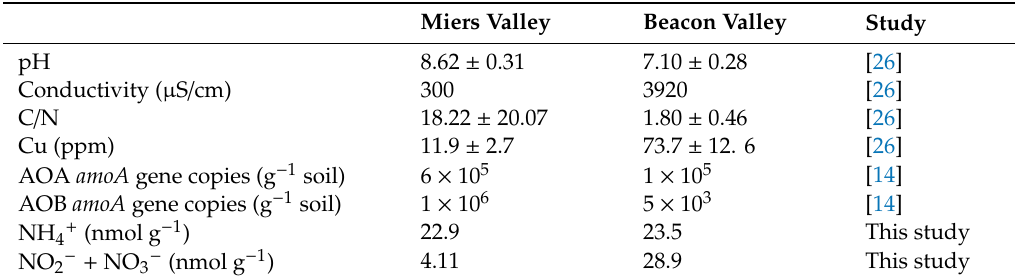
Table 1. Physicochemical properties of Miers and Beacon Valley soils.